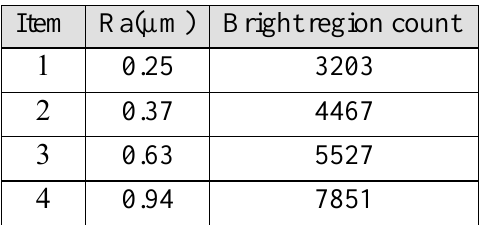
Table 2: Bright region values corresponding to surface roughness values with non-specular direction ( normal on surface).